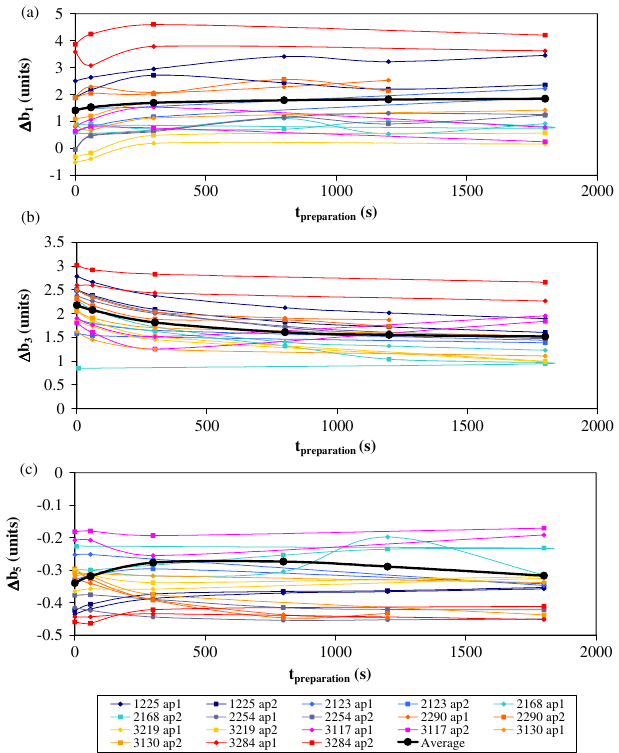
FIG. 15. (Color) The variation of the decay amplitude with preparation duration for (a) b